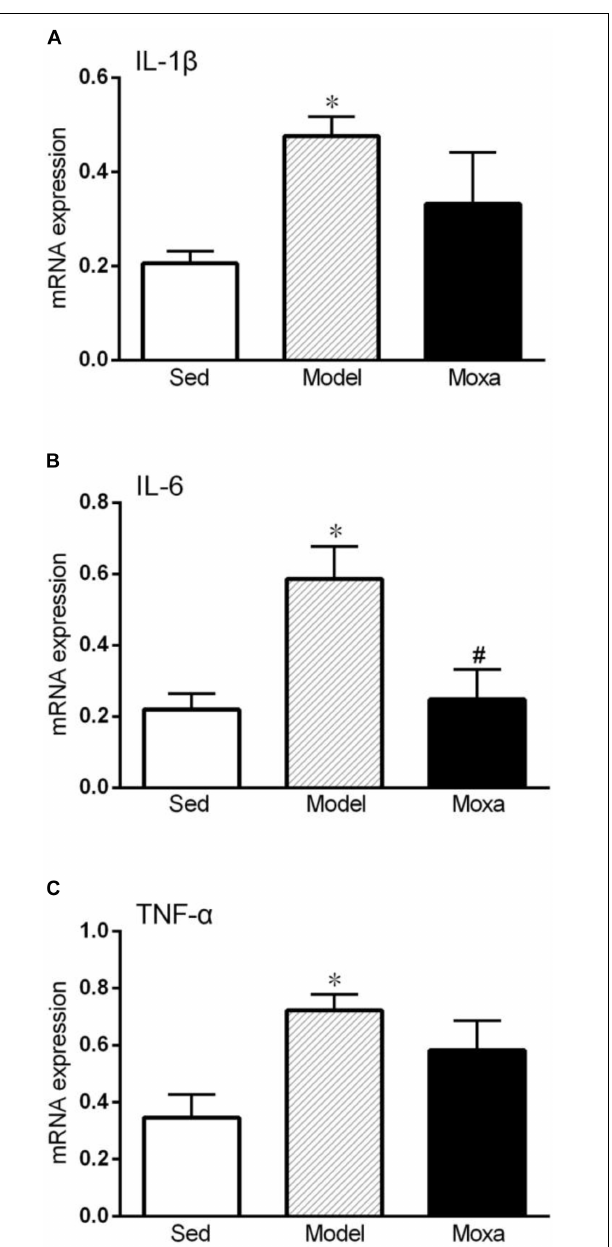
FIGURE 5 | Hippocampus cytokines gene expressions measured by RT-PCR in the following groups: Sedentary (Sed, N = 5), Model ( N = 5), Moxibustion (Moxa, N = 4). (A) Hippocampus gene expression level of IL-1 β . (B) Hippocampus gene expression levels of IL-6. (C) Hippocampus gene expression levels of TNF- α . Data are means ± SEM. ∗ P < 0.05 as compared with the Sed group, # P < 0.05 as compared with the Model